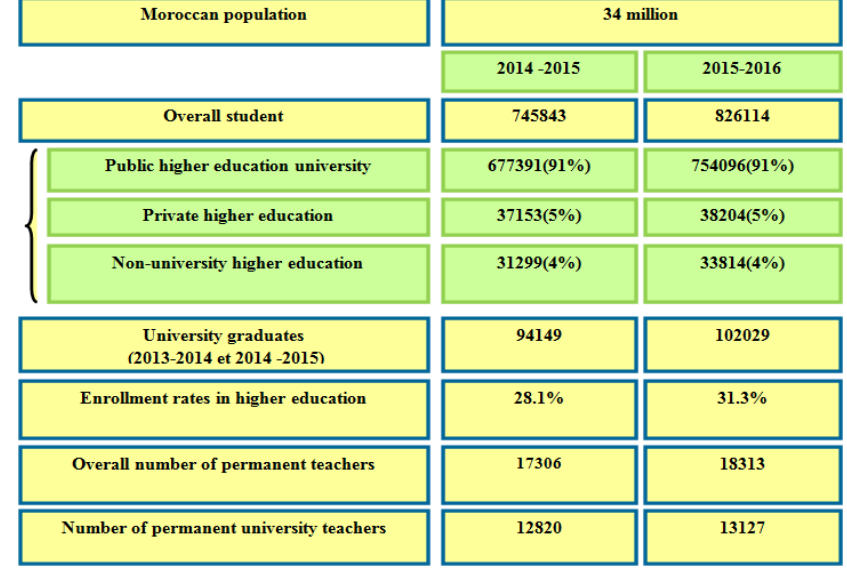
Fig. 2. Higher education in Morocco, key